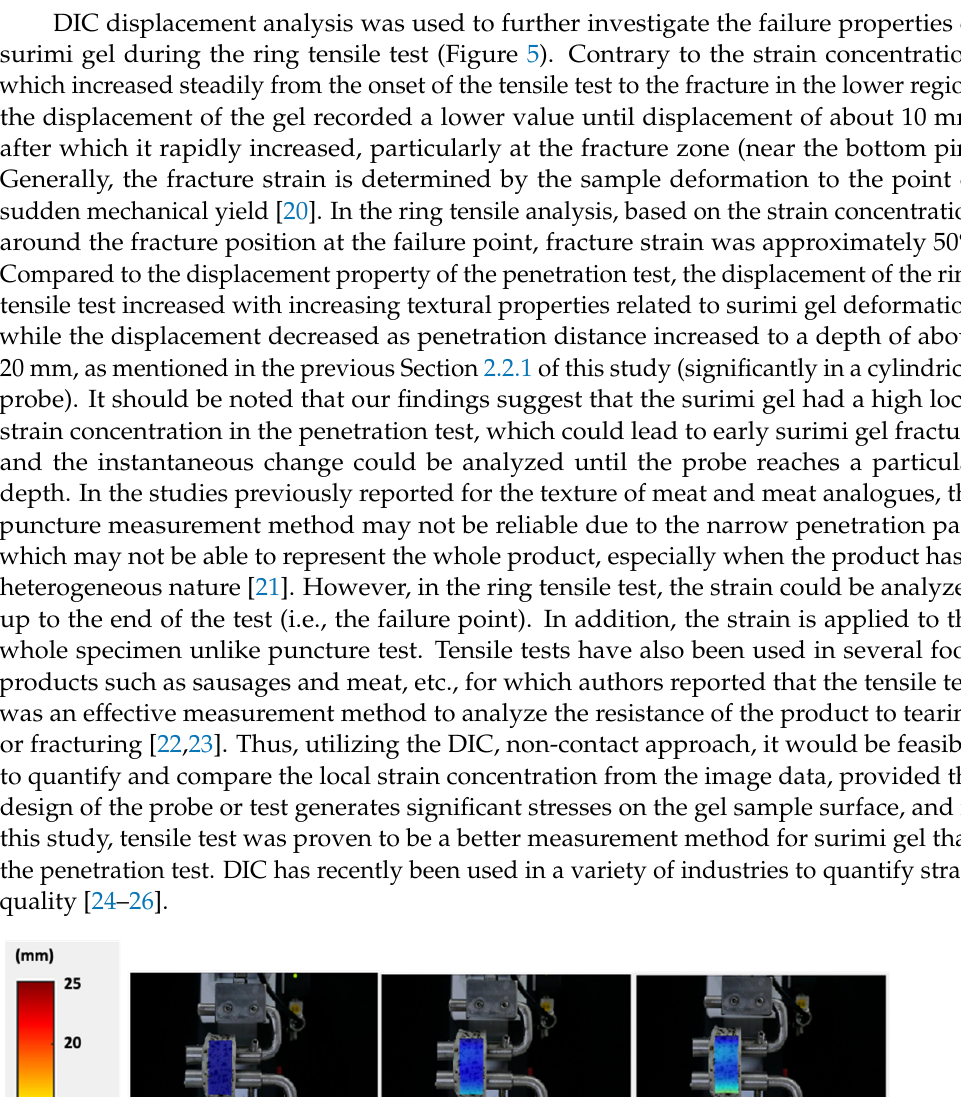
Figure 4. Contour plots of the strain component for surimi gel during the ring tensile test to the failure point.